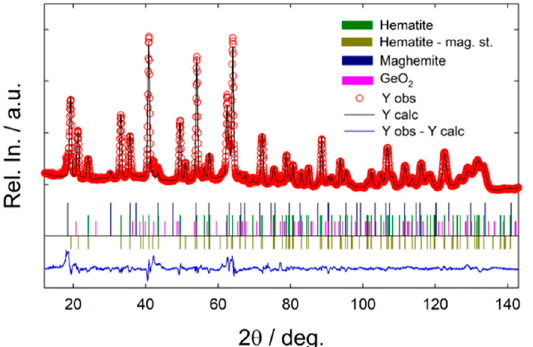
Figure 5. Rietveld refinement of the PND pattern of Fe 2 O 3 :Ge NFs ( χ 2 = 22.0, R p = 1.97, R wp = 2.39). Hematite 91.1%, Maghemite 8.6%, GeO 2 0.3%. Structural parameters: Hematite a = 5.031 (1) Å, c = 13.7416 (4) Å; Maghemite a = 8.33041 (41) Å.